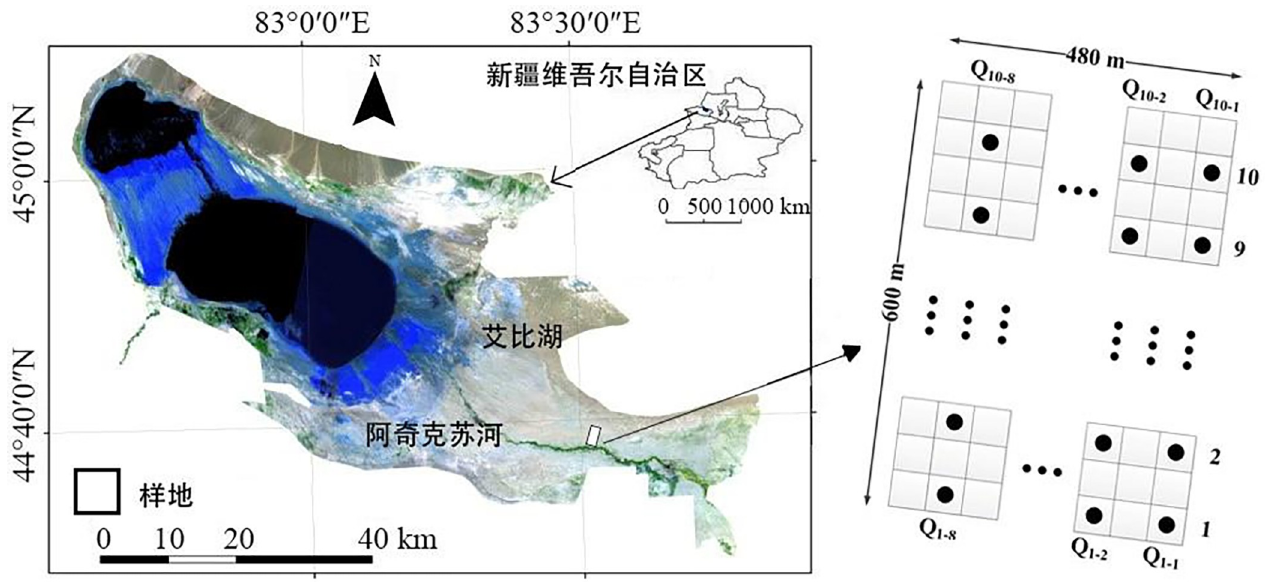
Fig 1. The study area and location of the plots. Autonomous Region is downloaded from The Gateway to Astronaut Photography of Earth website (https:// eol.jsc.nasa.gov/SearchPhotos/). Image courtesy of the Earth Science and Remote Sensing Unit, NASA Johnson Space Center. Because the map downloaded from this website is free and open to scholars, our study does not need to supply a copyright notice.